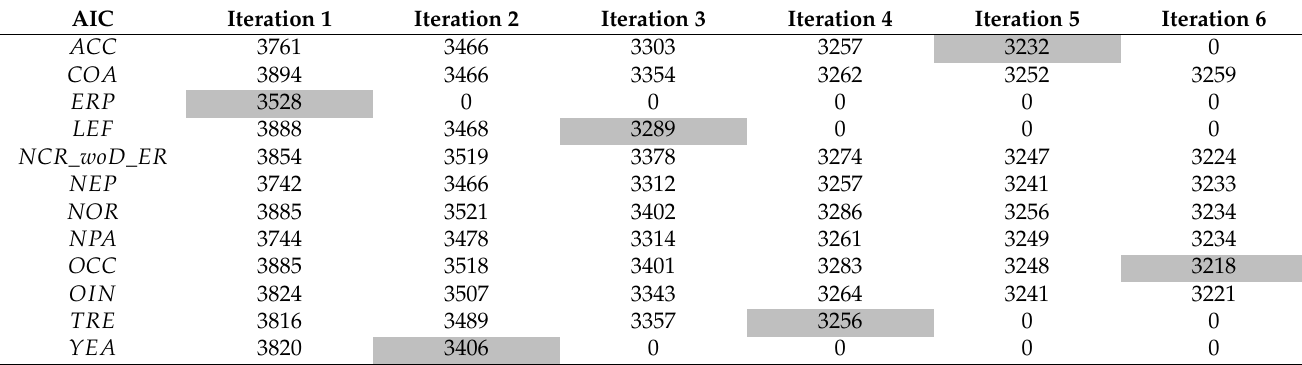
Table A3. AIC values of the explanatory variables for the reinsurance undertakings.